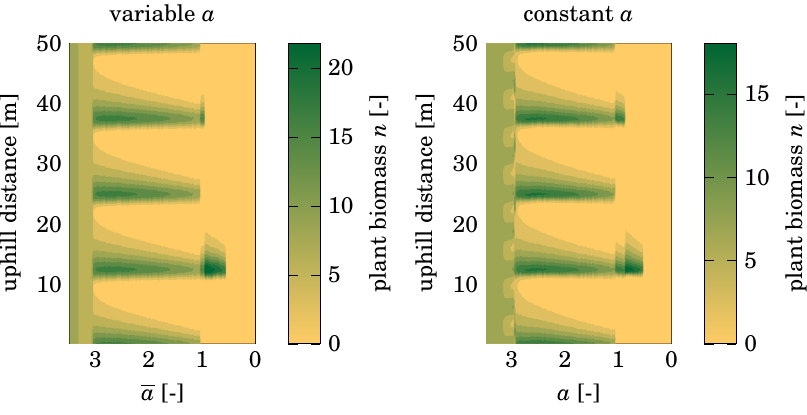
Figure 3. Results of the one-dimensional Klausmeier model after 1500 time-steps (to neglect transient dynamics) are shown for variable and constant precipitation. Resulting biomass peaks are shown for different values of mean precipitation. The maximum of plant biomass is located at 12.5 m uphill distance for each run to facilitate comparison and interpretation. As initial conditions, four peaks resulting from a model run with a = 2 have been